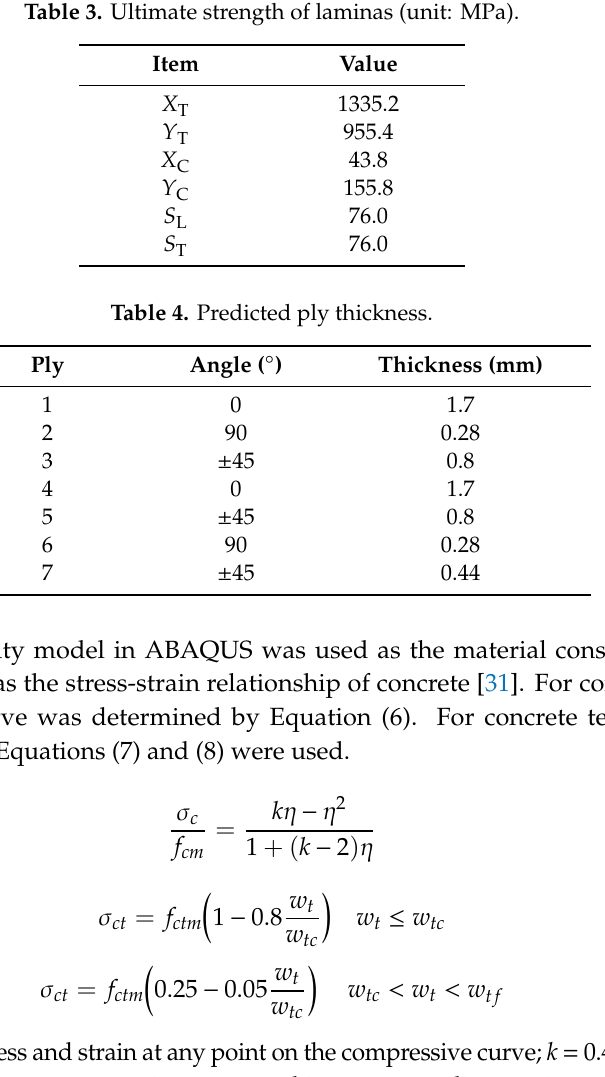
Table 3. Ultimate strength of laminas (unit: MPa).